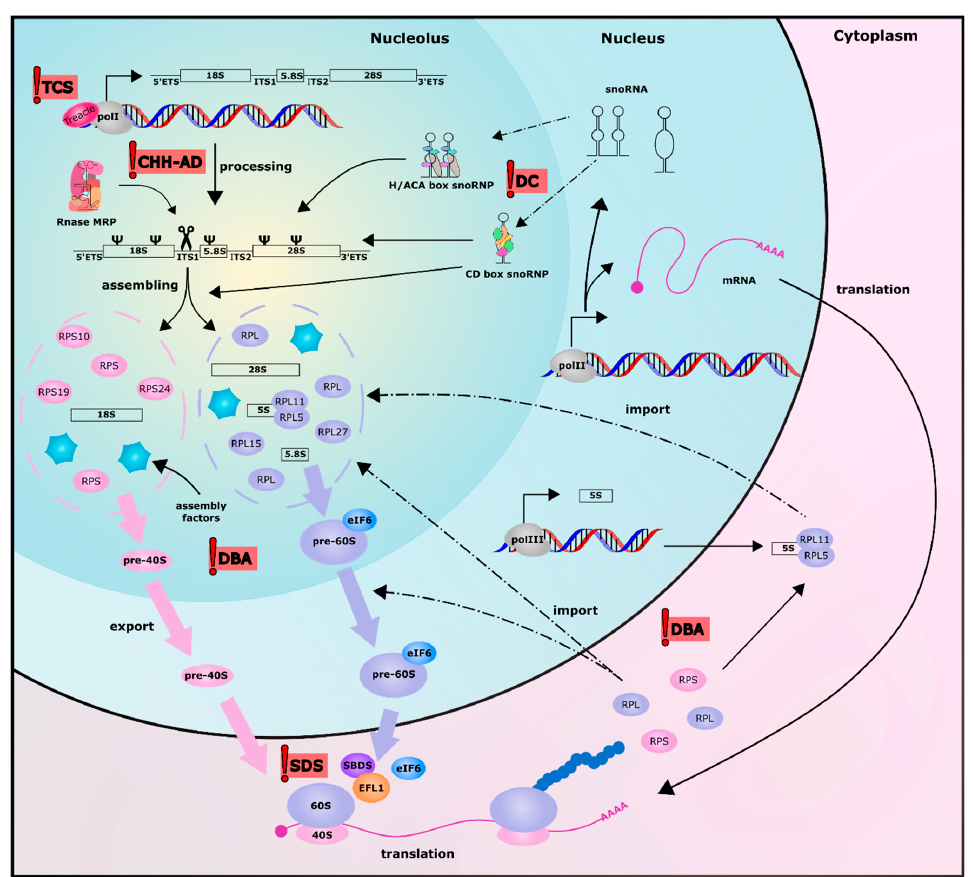
Figure 1. Schematic representation of the ribosome biogenesis process in human cells. The red flags highlight the steps where mutations in genes encoding for ribosomal proteins or for factors involved in ribosome biogenesis give rise to the five ribosomopathies originally identified: Treacher Collins syndrome (TCS), X-linked dyskeratosis congenita, cartilage hair hypoplasia-anauxetic dysplasia (CHH-AD), Diamond Blackfan anemia (DBA) and Schwachman-Diamond syndrome (SDS).